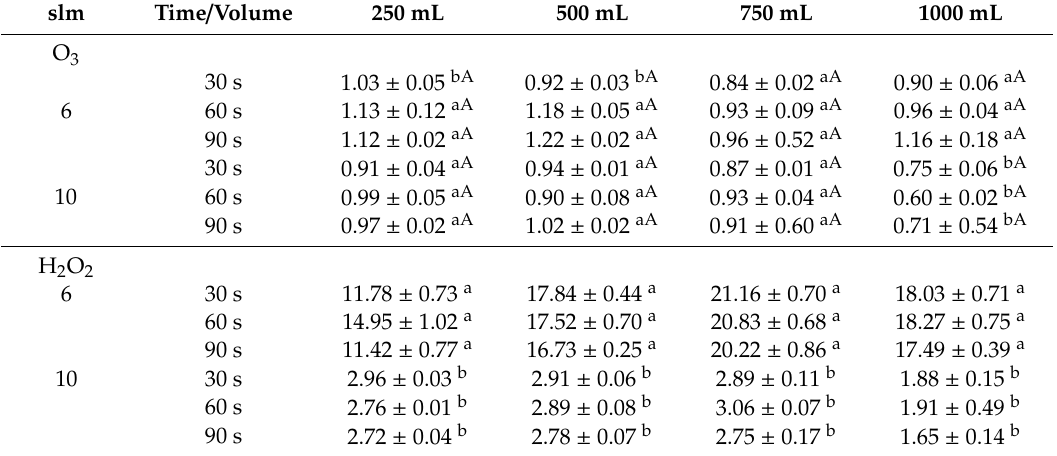
Table 6. The concentrations of ozone (O 3 ) and hydrogen peroxide (H 2 O 2 ) of the PAW generated by two plasma jets at 6 or 10 slm with di ff erent treatment times and water volumes.